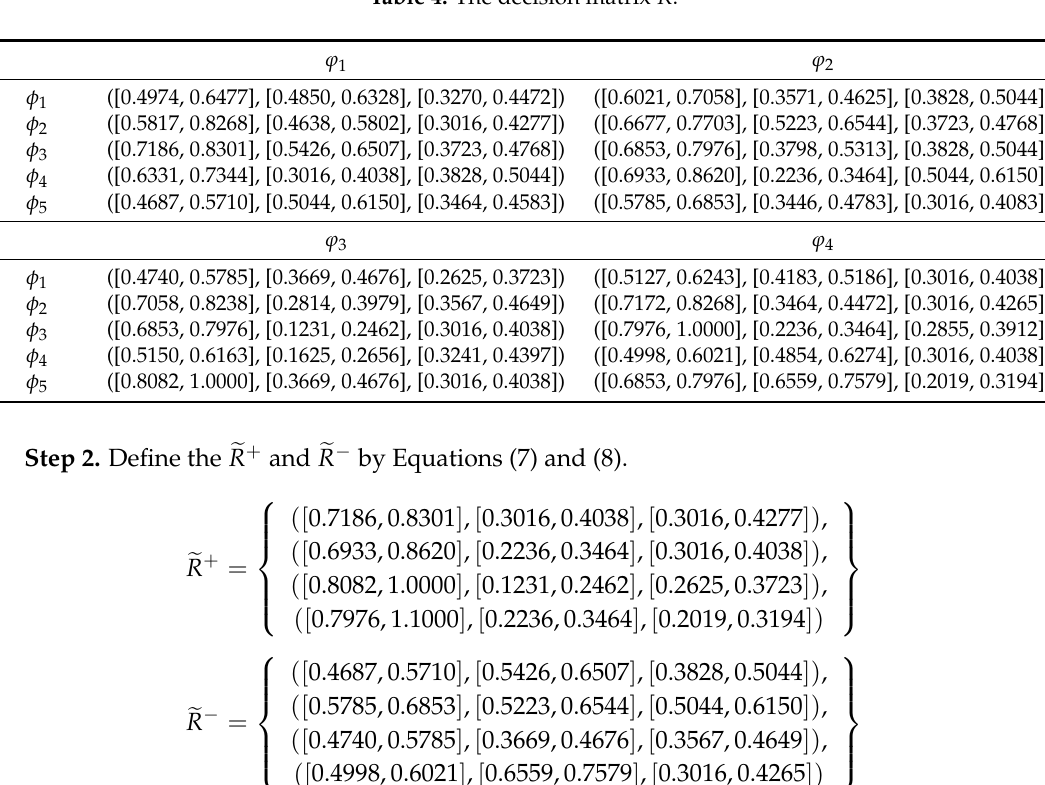
Table 4. The decision matrix (cid:101) R